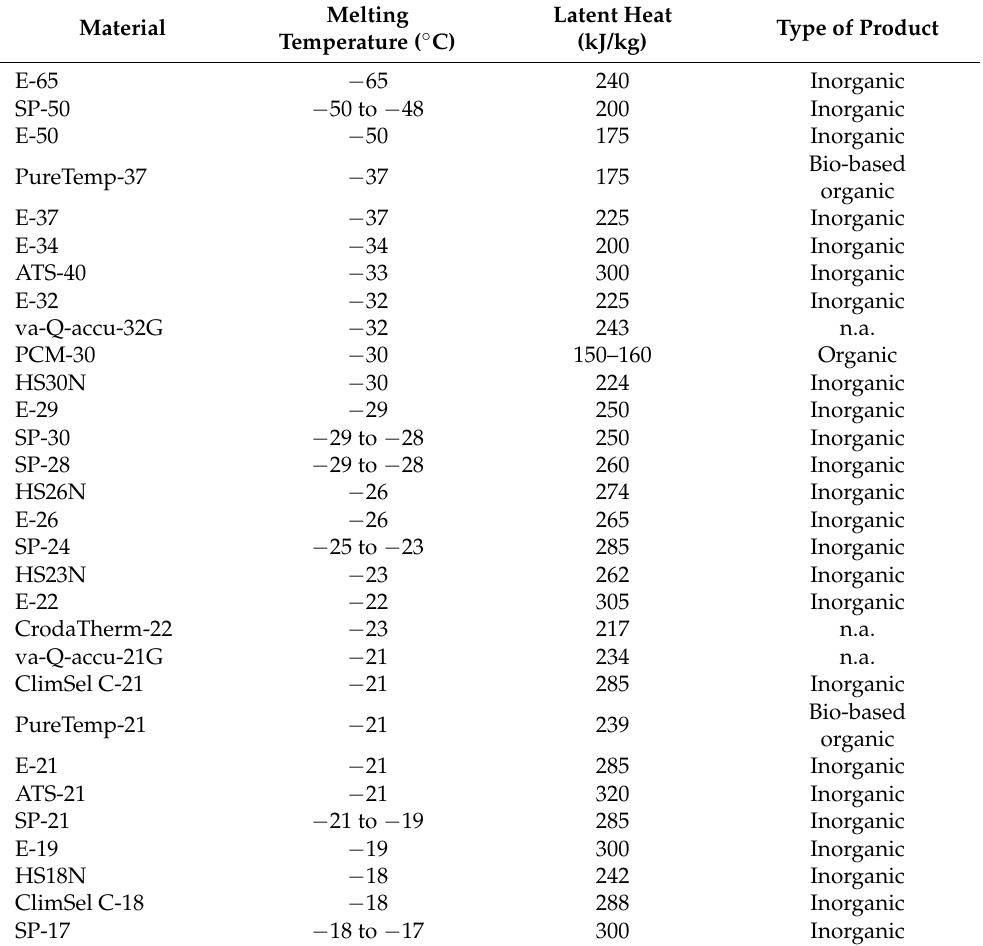
Table 13. Commercially available PCMs in the temperature range from − 65 ◦ C to 10 ◦ C. Reprinted from ref.